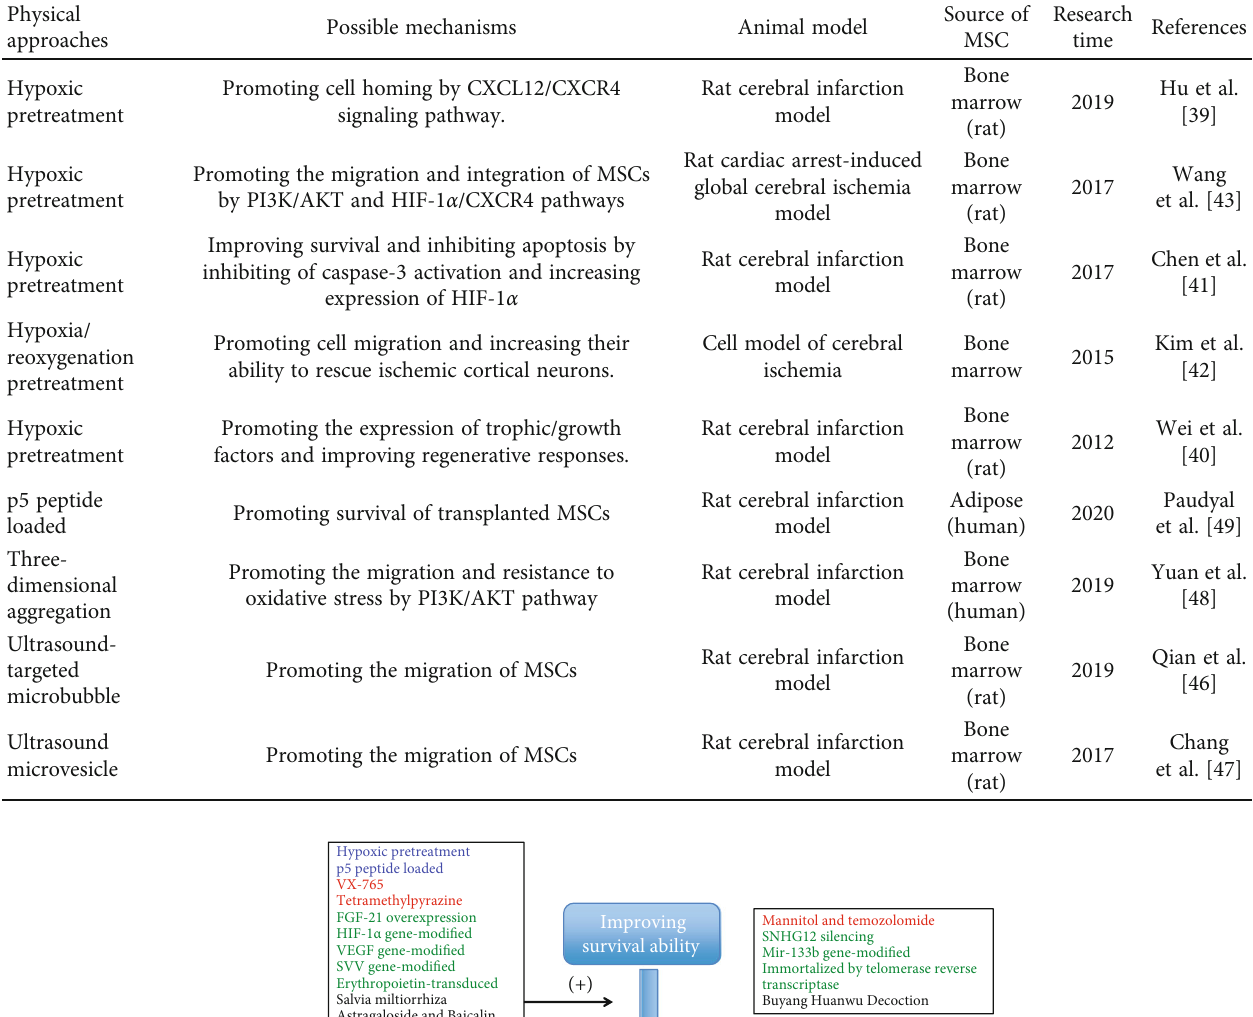
Table 1: Recent studies reporting physical approaches that can improve the e ffi ciency of MSC transplantation in ischemic stroke models.